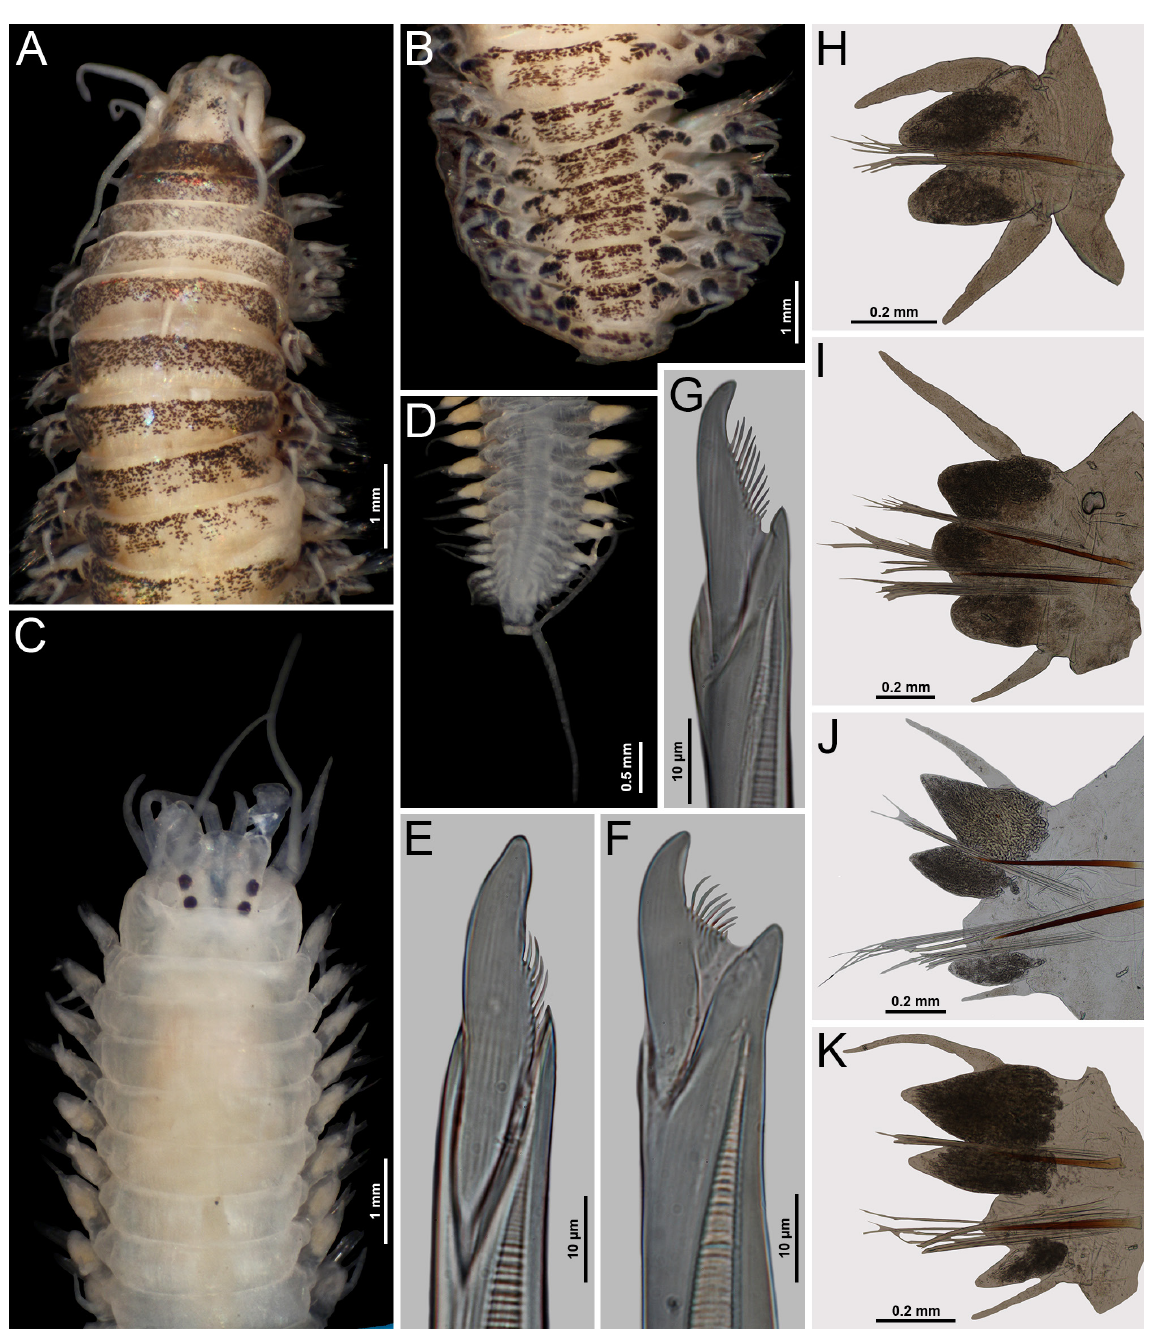
Fig. 9. Nereis marginata Grube & Örsted in Grube, 1857 reinstated, non-type, atoke specimens. A–B, E–K: ECOSUR P3104; C–D: UMML 22.1174. A . Anterior region, dorsal view. B . Posterior